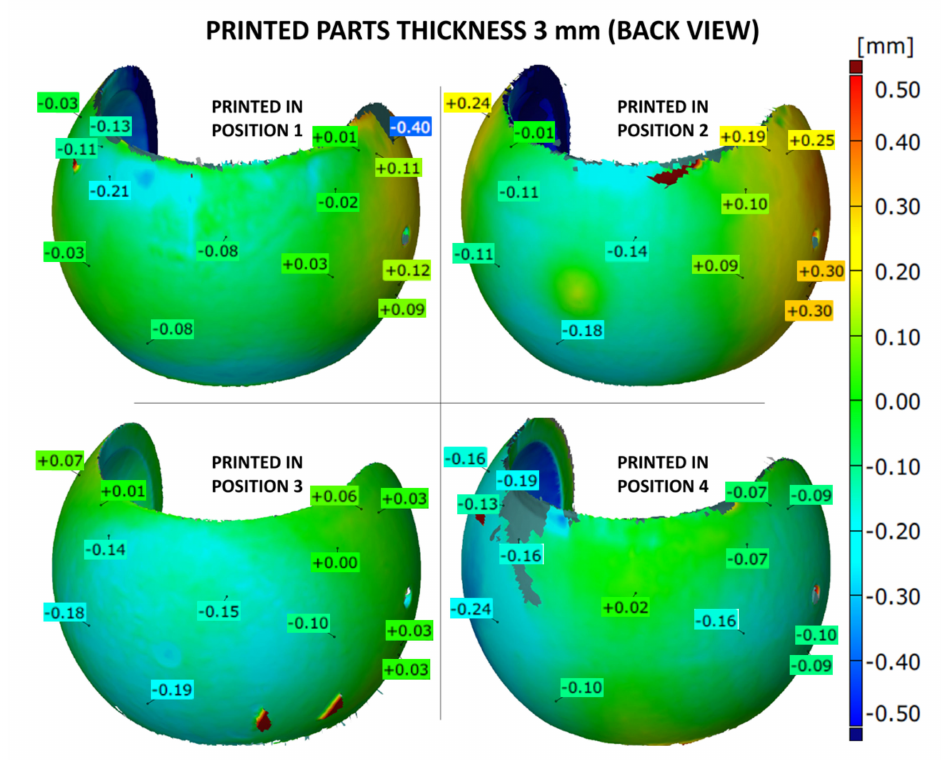
Figure 12. Geometry deviations of the 3D printed part with a thickness of 3 mm (back